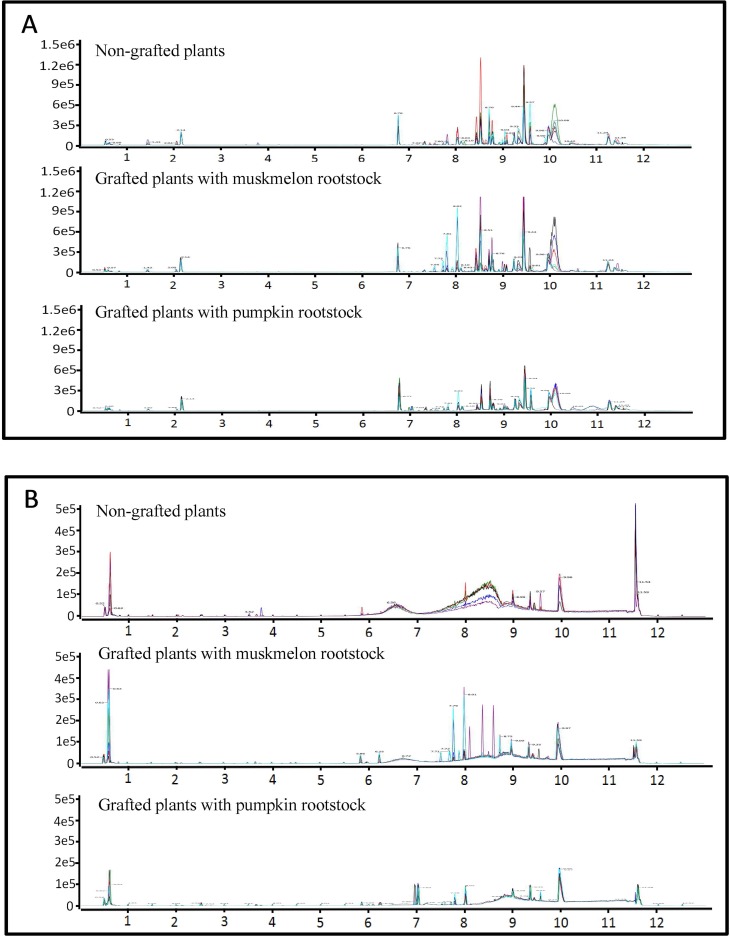
Base peak intensity (BPI) chromatograms of melon fruits from non-grafted plants and plants grafted onto either muskmelon or pumpkin rootstocks.(A) BPI chromatogram in positive mode. (B) BPI chromatogram in negative mode.